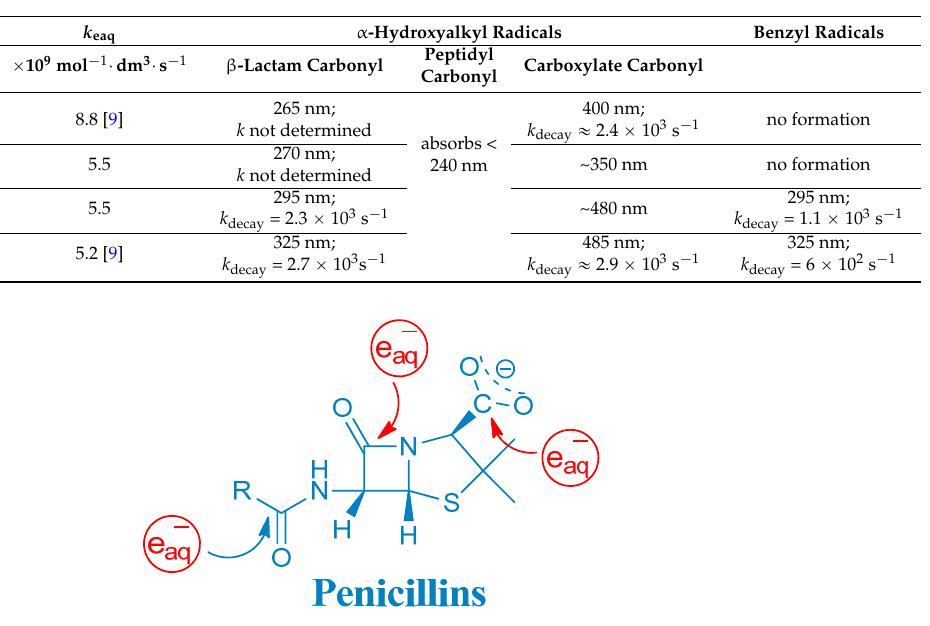
Table 2. Summary of the radical intermediates with a general reaction mechanism below.